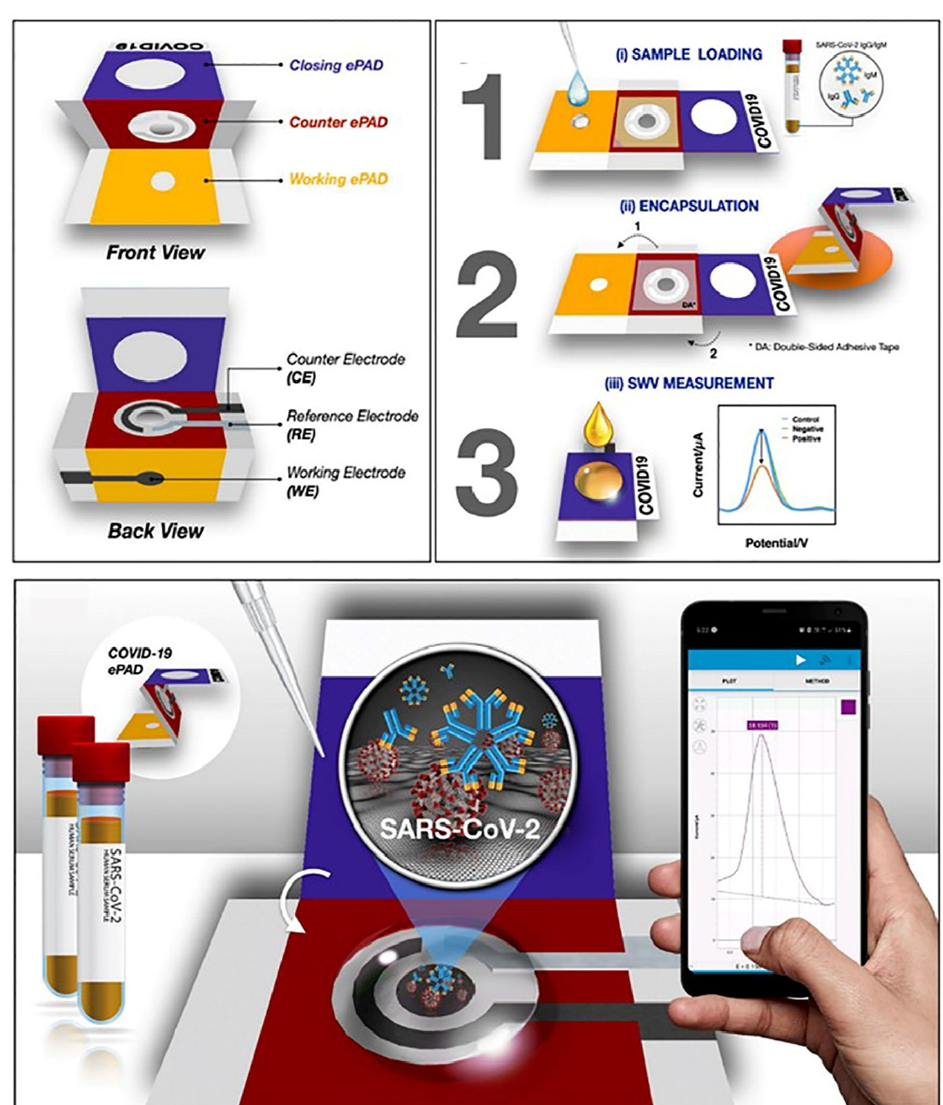
Figure 4. Electrochemical immunosensors for SARS-CoV-2 detection. Components and detection principle of the paper-based immunosensor (COVID-19 ePAD) for antibody detection. Reproduced with permission from [32]. Copyright 2021,